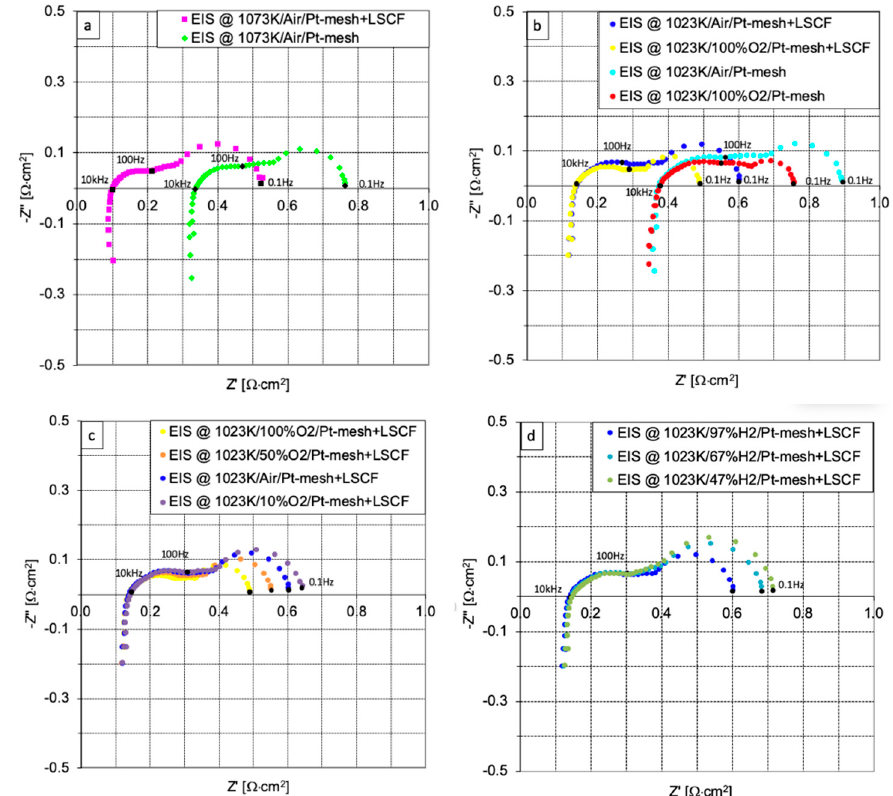
Figure 2. Nyquist plots measured at OCV at different temperatures: ( a ) 1073 K and ( b ) 1023 K; and different gas compositions at ( c ) cathode and ( d ) anode sides. The 10 kHz, 100 Hz and 0.1 Hz frequencies are marked in the plots.